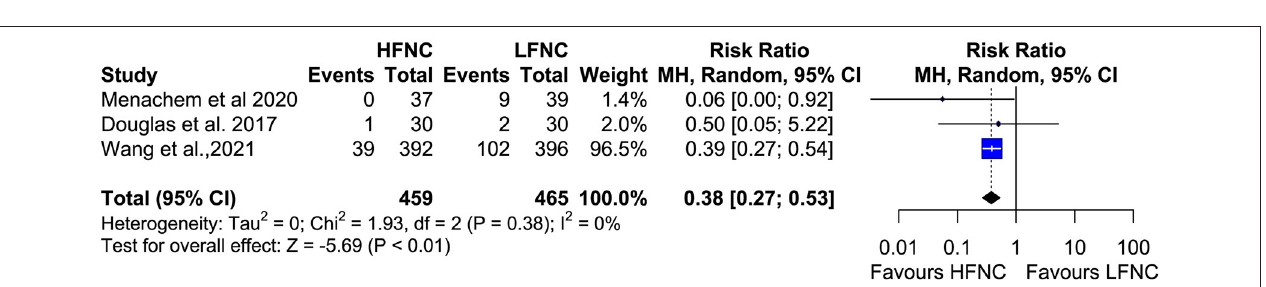
FIGURE 14 | Meta-analysis of procedural interuptions in patients receiving HFNC compared to LFNC in patients undergoing bronchoscopic